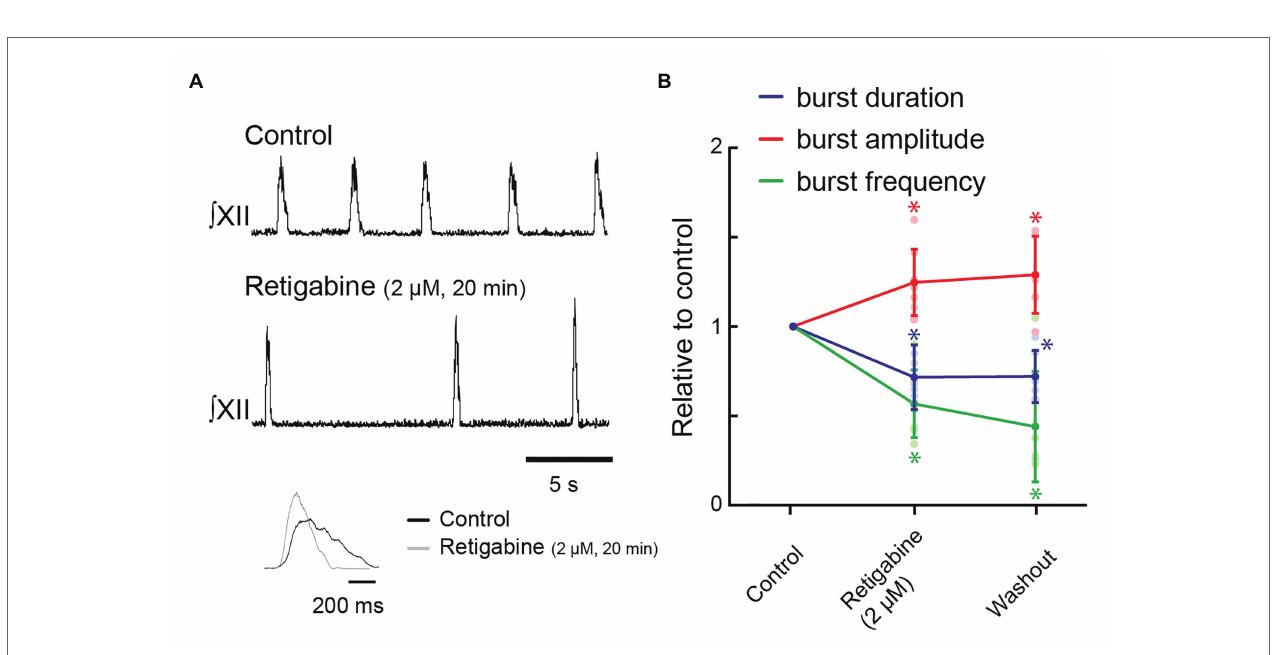
FIGURE 5 | Effects of activating KCNQ channels with retigabine in the bath on inspiratory burst parameters in the rhythmic slice preparation. (A) Rectified, integrated recordings from XII nerve rootlets demonstrating inspiratory burst parameter changes in the presence of bath application of retigabine. Inset shows an average of 10 inspiratory bursts in control (black) and after 60 min of bath application of 2 μ M of retigabine (gray). (B) Group data from XII nerve rootlet recordings where retigabine was applied to the bath at 2 μ M, n = 8 for control and 2 μ M of retigabine, n = 6 washout. * p < 0.05, mixed-effects model with Tukey’s multiple comparisons post hoc test.